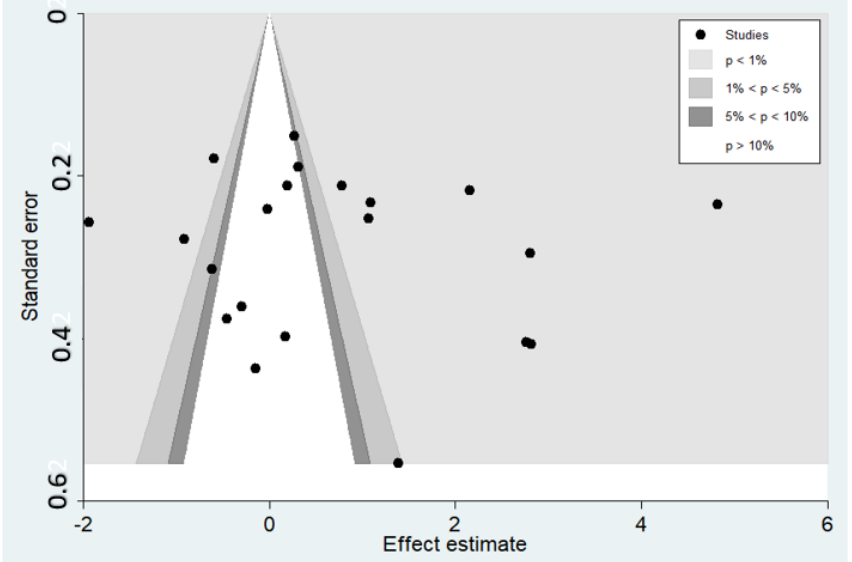
Figure 10. Contour ‐ enhanced funnel plot illustrating the distribution of the SMD of IL ‐ 10 levels and Figure 10. Contour-enhanced funnel plot illustrating the distribution of the SMD of IL-10 levels and their standard error (se) in significant and non ‐ significant areas. their standard error (se) in significant and non-significant